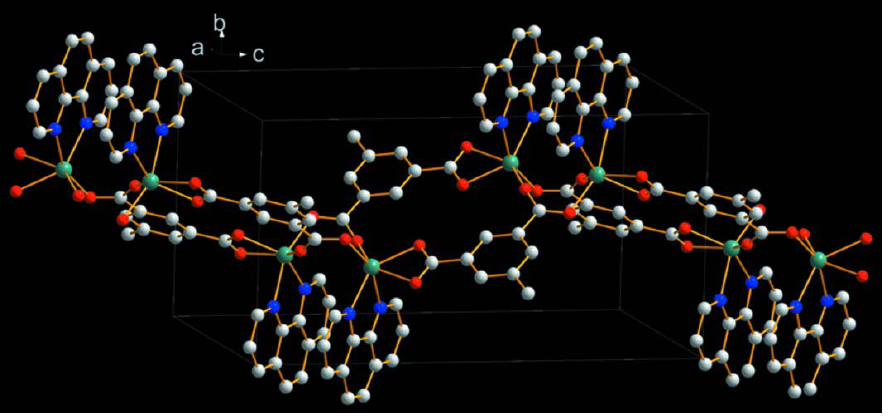
Figure 2 A portion of the stranded polymeric ribbon in (I). catena-Poly[[(1,10-phenanthroline)manganese(II)]- µ